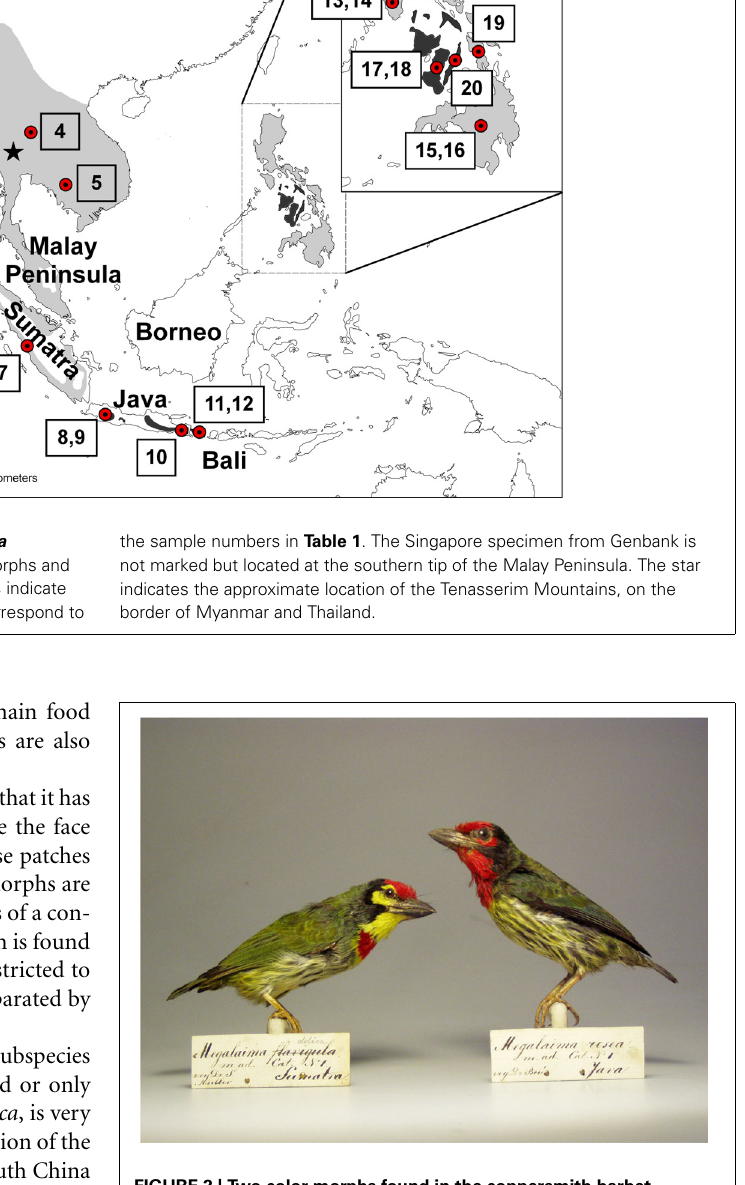
FIGURE 2 | Two color morphs found in the coppersmith barbet (housed at the Netherlands Center for Biodiversity (NCB) Naturalis, Leiden, The Netherlands). On the left is a yellow morph specimen collected on Sumatra and on the right a red morph from Java (©NCB Naturalis, Leiden, the